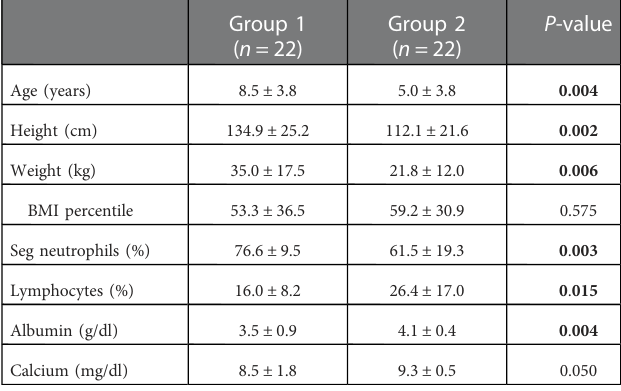
TABLE 4 Comparison of the mean values of independent variables after propensity score matching with age, height, and